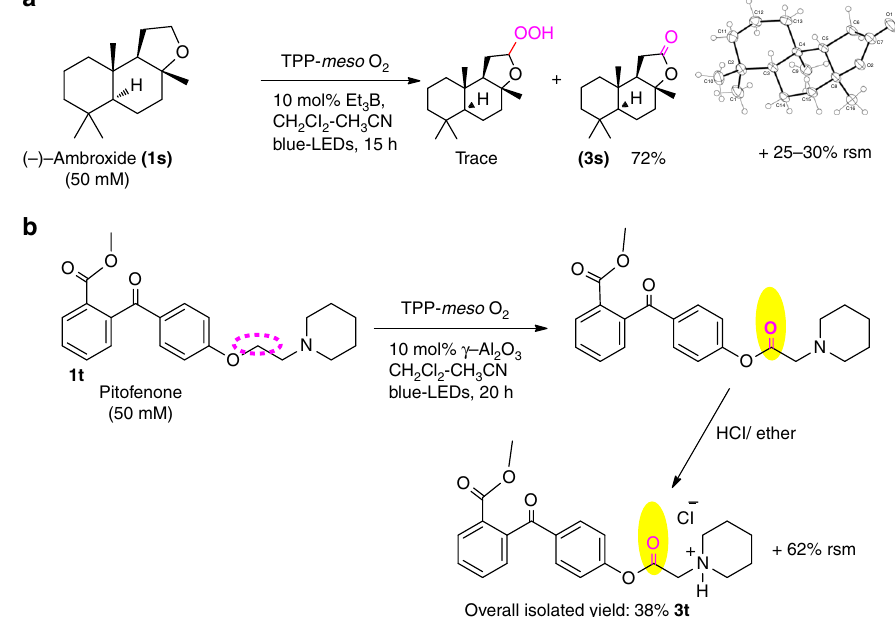
Fig. 2 Singlet oxygen reaction with structurally complex substrates. Singlet O 2 -mediated direct aliphatic α -ethereal C – H oxidative functionalization of substrates: ( a ) (-)-ambroxide, and ( b ) pitofenone. Rsm: recovered starting material. The yield refers to the isolated product after workup